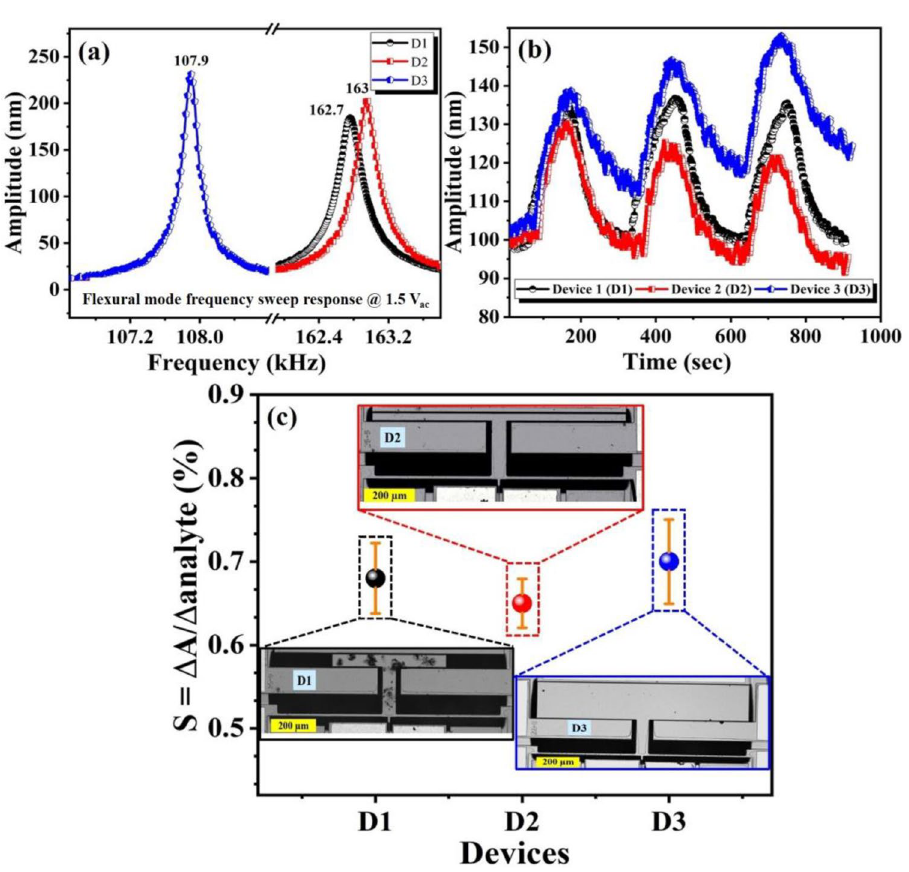
Figure 13. Dynamic and sensing characterizations of all three devices (D1,D2, and D3), ( a ) frequency sweep response, ( b ) 50% He response at flexural mode, ( c ) sensitivity results with error bars for D1, D2, and D3. Insets show the microscopic images of the